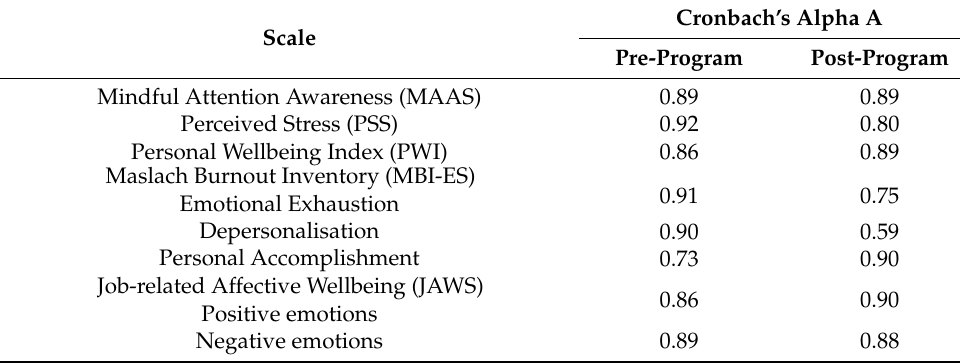
Table 4. Cronbach’s alpha calculations for the self-report measures ( n =